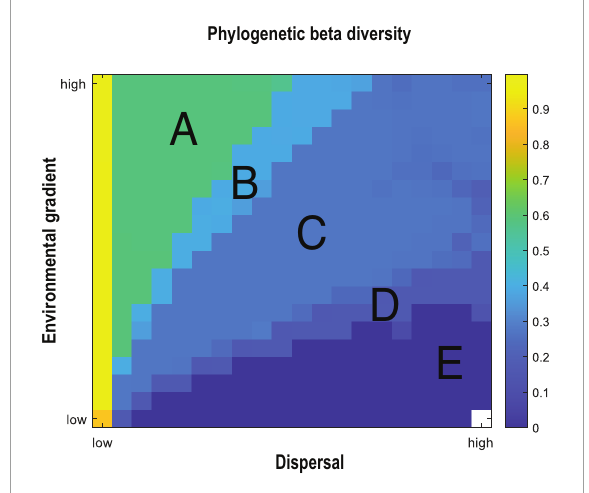
FIGURE5 The phylogenetic beta diversity (PBD) reveals the interaction of the environmental gradient ( y -axis) and dispersal ( x -axis). Each grid indicates a simulation with a respective combination of environmental gradient and dispersal. PBD is then calculated by comparing all the possible pairwise phylogenetic relatedness between the habitats. We then take the average of the pairwise values. When PBD equals 1, there is no shared evolutionary history between species living in two compared habitats. When PBD equals 0, species living in both habitats share an identical evolutionary history. An extinction threshold of 1 is introduced to define whether a species is present or absent.